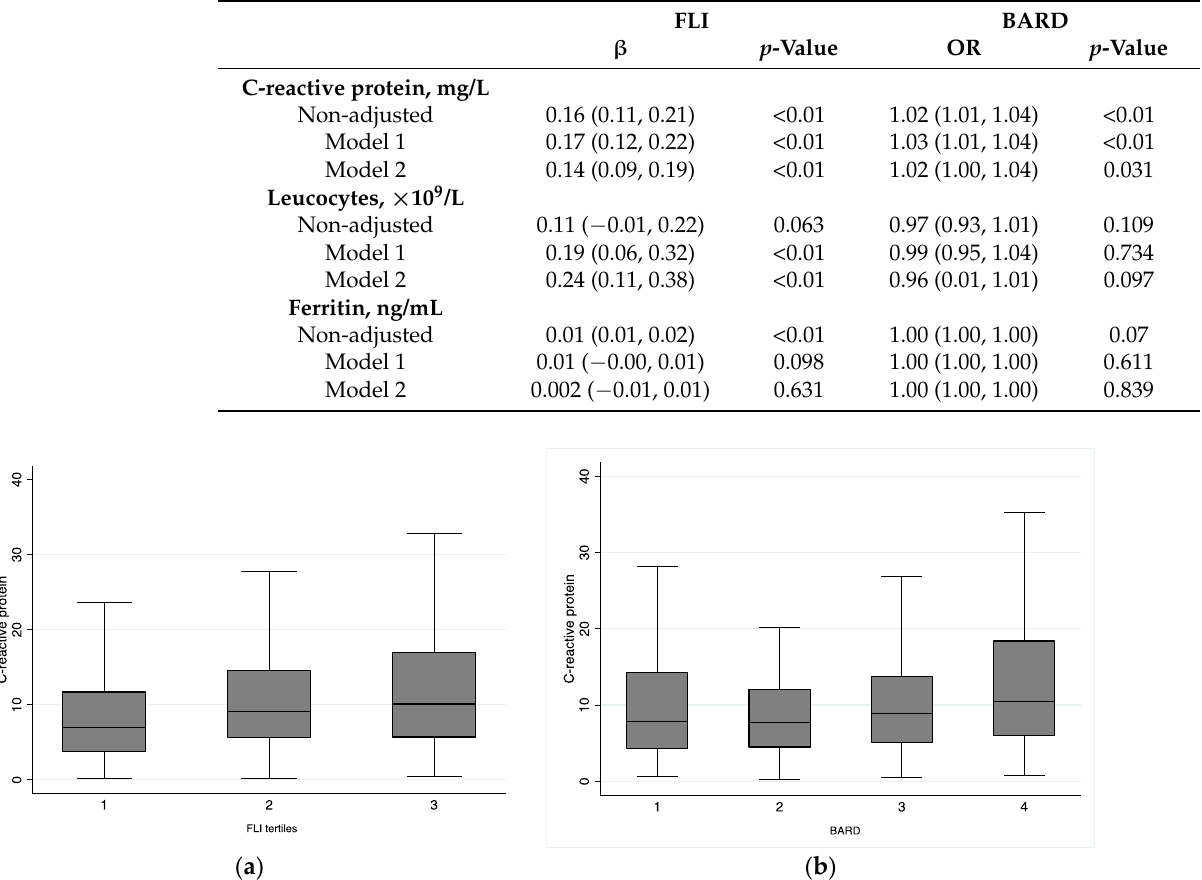
Table 3. Association between inflammatory markers and FLI and BARD scores. Model 1—adjusted for age and sex; model 2—adjusted for age, sex, BMI, diabetes, and dyslipidemia. Abbreviations: FLI, Fatty Liver Index; BARD, BMI, AST/ALT ratio, and presence of diabetes.